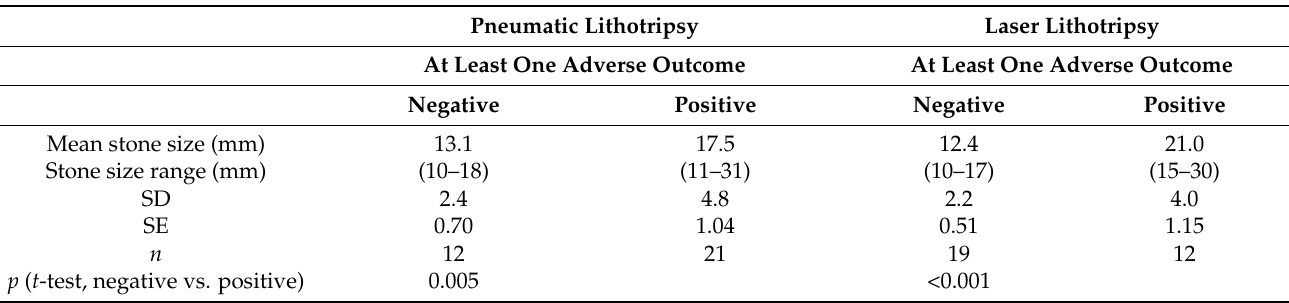
Table 2. Differences in mean stone size between patients with at least one adverse outcome and those without adverse outcomes in both groups.